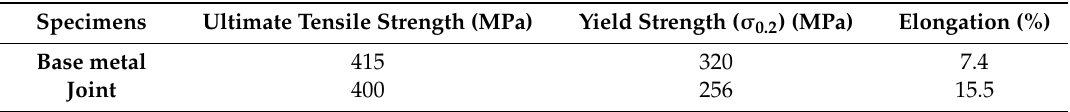
Table 2. Tensile properties of base metal and the